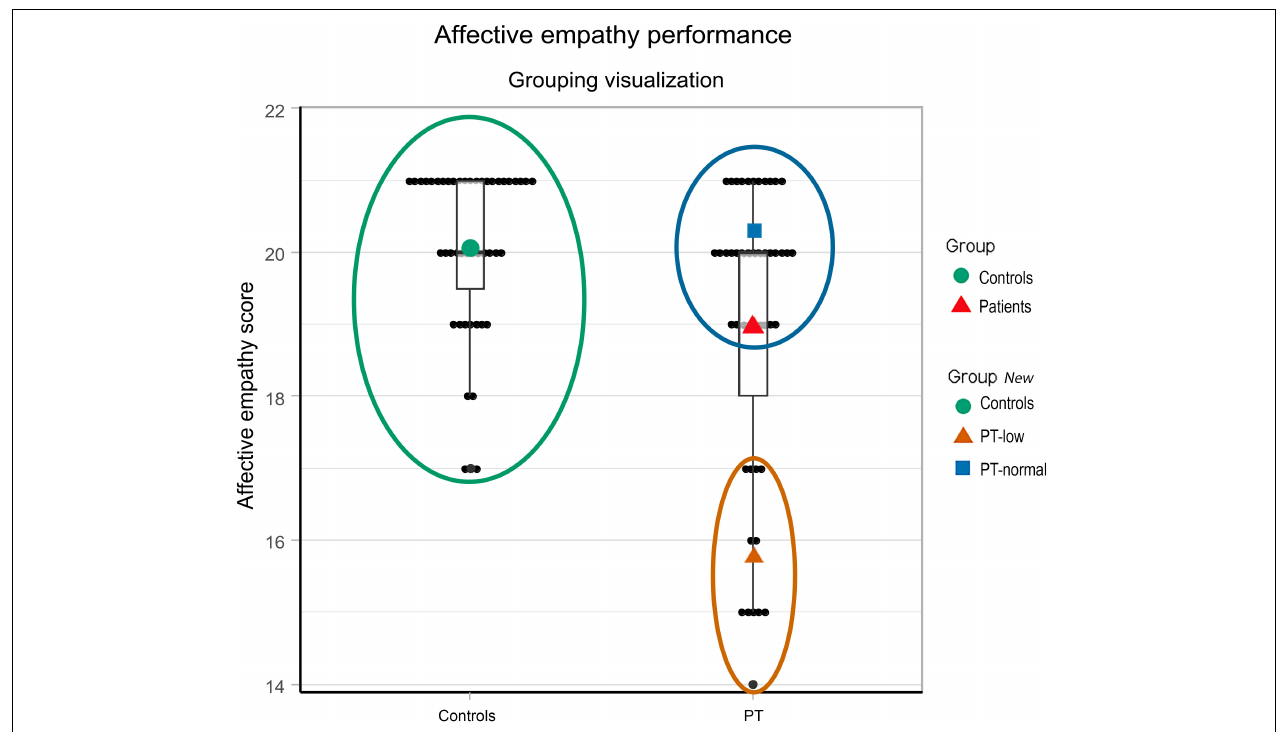
FIGURE 2 | Performance on the affective empathy task in patients with schizophrenia and controls. Black dots represent individual scores. The green circle defines the control group with the green dot indicating the mean performance. The red triangle gives the mean affective empathy score of the patients, which was significantly lower than in controls ( p < 0.001). For further analyses, we defined two groups of patients based on their performance on the emotion recognition task, i.e., those patients who performed in the same range as controls (PT-normal, represented in the blue circle) versus those scoring equal or lower than the control participant with the lowest score (PT-low, shown in the orange